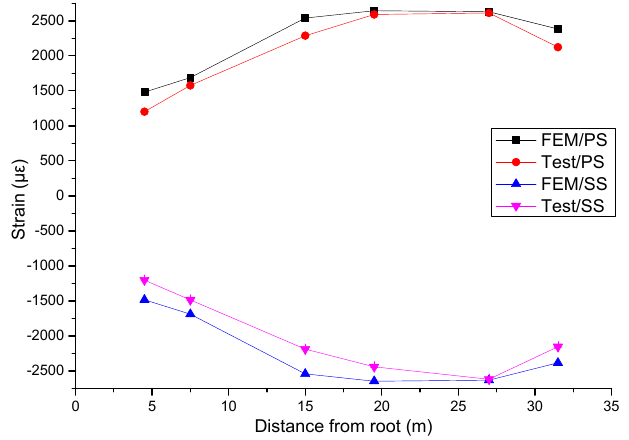
Figure 12. Comparison of the strain value on the spar cap between FEM and measured results.